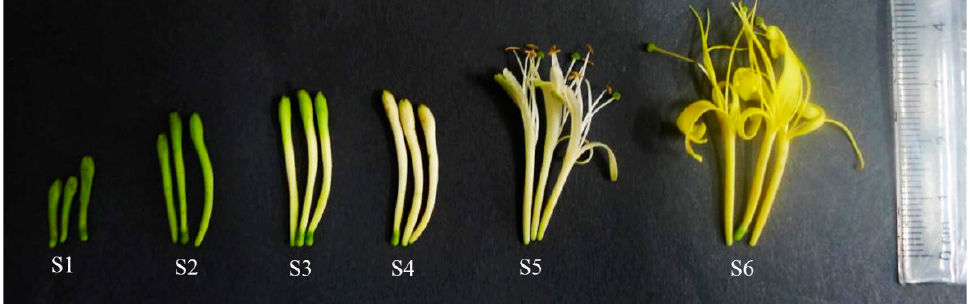
Fig. 2: Morphological changes in the buds and flowers of L. fulvotomentosa at different growth stages from S1 to S6. S1: The stage of young alabastrum; S2: The stage of green alabastrum; S3: The stage of slightly white alabastrum; S4: The stage of whole white alabastrum; S5: The stage of silvery flower; S6: The stage of golden flower.